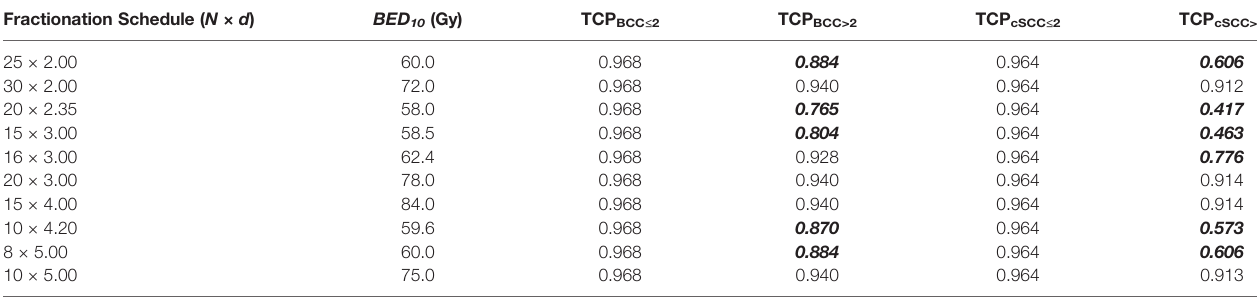
TABLE 3 | Tumor Control Probability (TCP) for different radiation schedules by tumor type and size.